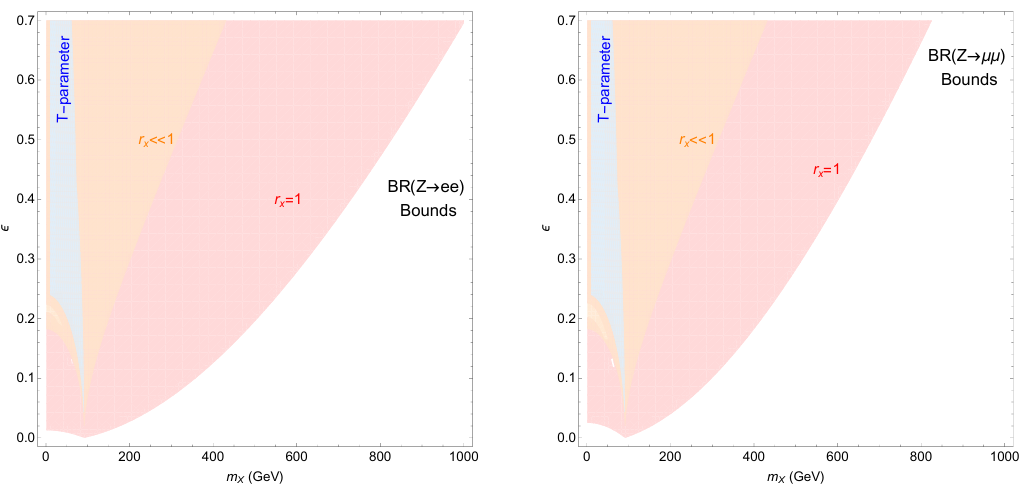
Figure 4 . Bounds from precision Z measurements for m T = 500 GeV. The orange (red) regions take g X (cid:28) g ( g X = g ), where g is the SM weak gauge coupling. The red region assumes X couples to B (cid:0) L , giving a stronger bound. These two regions illustrate how strong or weak the bounds can be. The T -parameter bound also shown in